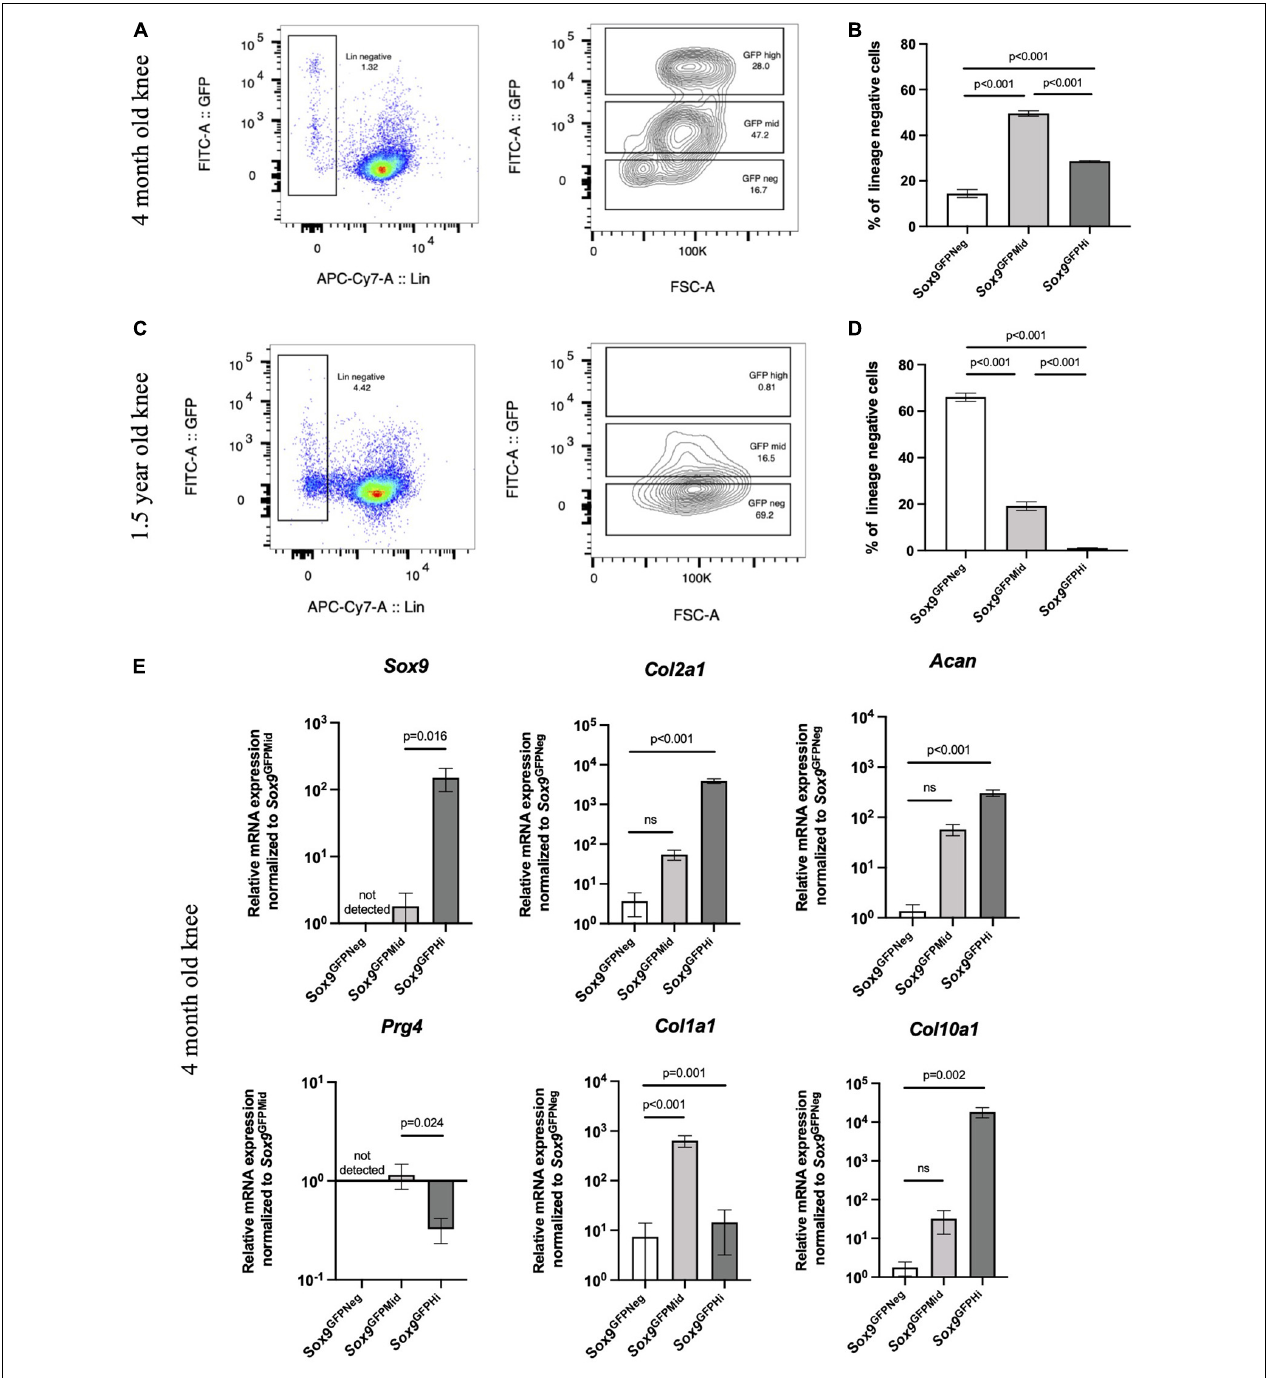
FIGURE 5 | Sox9 GFPHi cells in the knee joint show highest chondrogenic gene expression but diminish with age. Representative FACS plot (A) and quantification (B) of Sox9 GFP levels in 4 months old Sox9 GFP knee joint; n = 3 biological replicates. Representative FACS plot (C) and quantification (D) of GFP levels in 1.5 years old Sox9 GFP knee joint; n = 3 biological replicates. (E) qPCR of chondrogenic genes in 4 months old Sox9 GFP cells in the knee joint, n = 6 biological replicates. Data represented as mean ± SEM and all p -values calculated using one-way ANOVA with Tukey’s correction for multiple